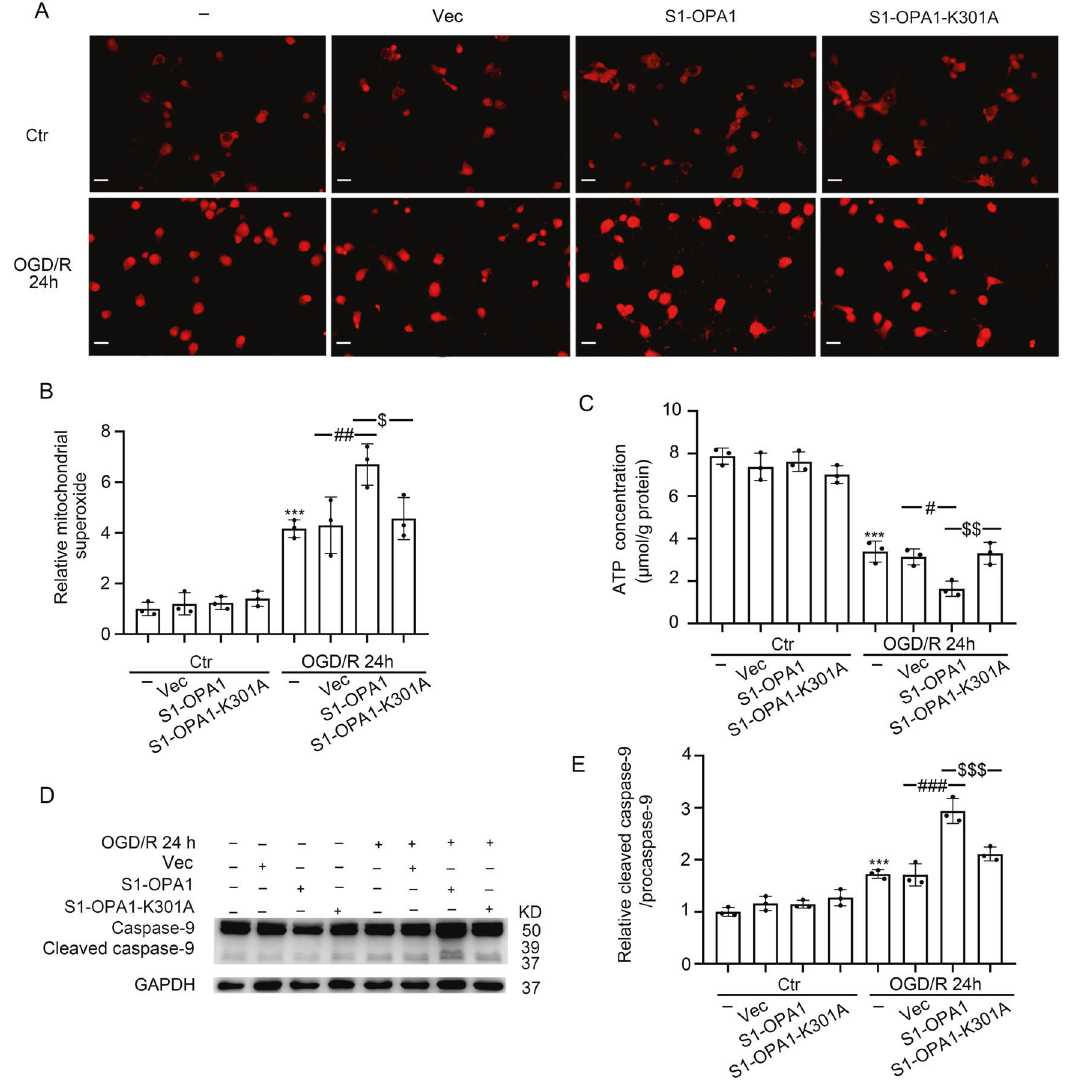
Fig. 4 S1-OPA1 overexpression induced mitochondrial superoxide generation, mitochondrial bioenergetic de fi cits, and mitochondrial apoptosis after OGD/R. A Representative images of Mito-Sox staining in different overexpression groups under normal condition and OGD/R for 24 h. B Quantitative analysis of superoxide generation in neurons through red fl uorescence intensity. C ATP content in neurons of each group was leveled by protein concentration. D Western blot analysis of caspase-9 and cleaved caspase-9 in neurons. E Ratio of cleaved caspase-9 to caspase-9 was quantitatively analyzed to represent the level of mitochondrial apoptosis. *** p <0.001 vs. control group, ### p <0.001, ## p <0.01, # p <0.05, $$$ p <0.001, $$ p <0.01, $ p < 0.05; scale bar = 20 μ m; n =